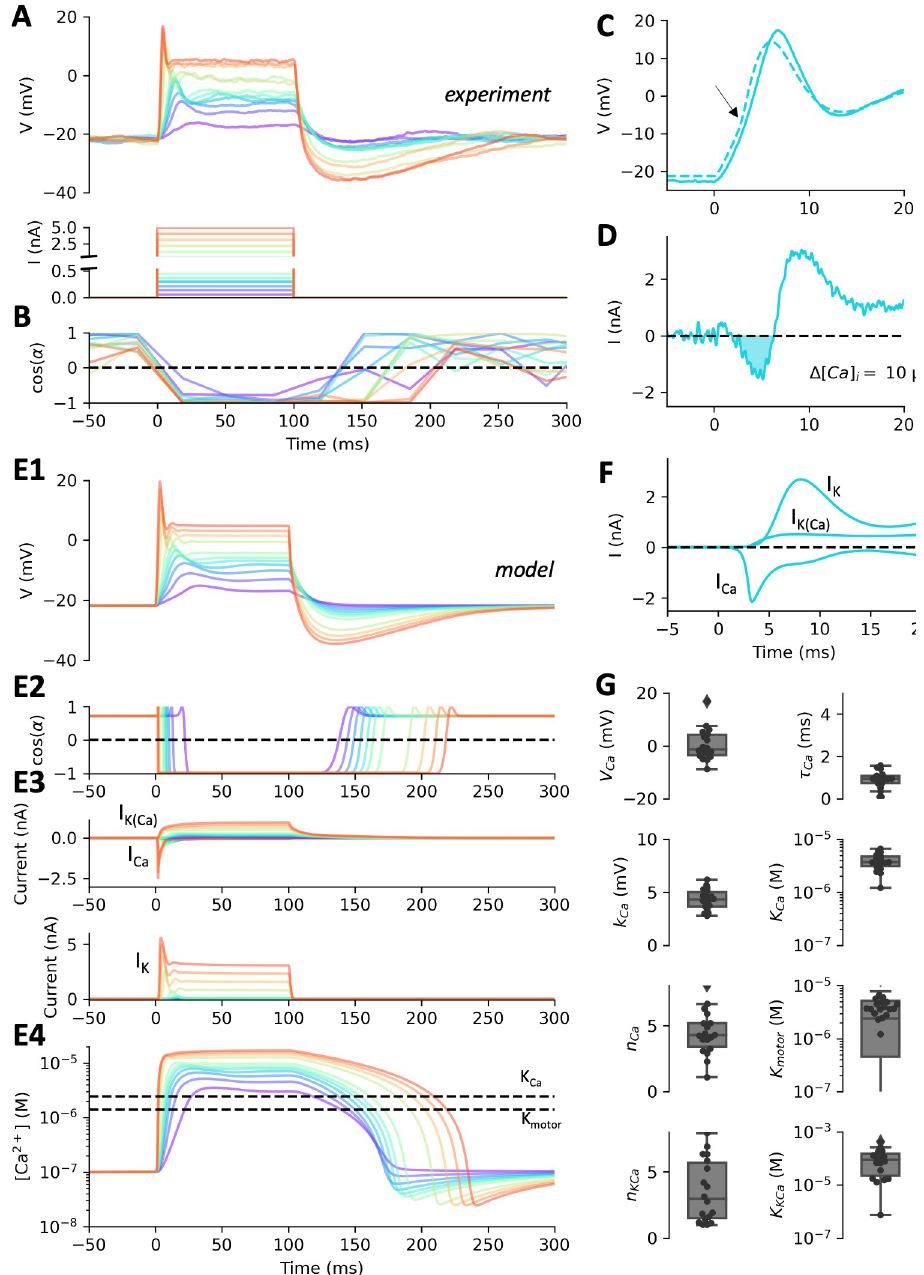
Fig 7. Fitting the action potential of Paramecium. A, Voltage responses of a cell (top) to two sets of current pulses (bottom), from 0 to 5 nA (in 300 pA increments) and from 0 to 300 pA (in 25 pA increments). B, Ciliary response to the same currents, measured as the cosine of the mean angle of the velocity field, relative to the anteroposterior axis. C, Close up of an action potential triggered by a 1.5 nA current pulse, with the model fit (dashed). The arrow points at an upward deflection due to the calcium current. D, Ionic current calculated by subtracting the estimated leak current from the capacitive current. The inward current (I < 0, shaded) corresponds to the calcium current. Integrating this current yields a calcium entry corresponding to a 10 μ M increase in intraciliary calcium concentration. E, Responses of the fitted model. E1, Voltage responses. E2, Ciliary responses. E3, Voltage-gated calcium current I Ca (top, negative traces), delayed rectifier K + current I Kd (bottom) and calcium-activated K + current I K(Ca) (top, positive traces) in the fitted model. Currents are shown with the electrophysiological convention, i.e., I < 0 is inward. E4, Intraciliary calcium concentration in the fitted model. The dashed lines show the ciliary reversal threshold and the half-inactivation concentration. F, Ionic currents inferred by the model for the action potential shown in C. G, Statistics of fitted parameters (n =